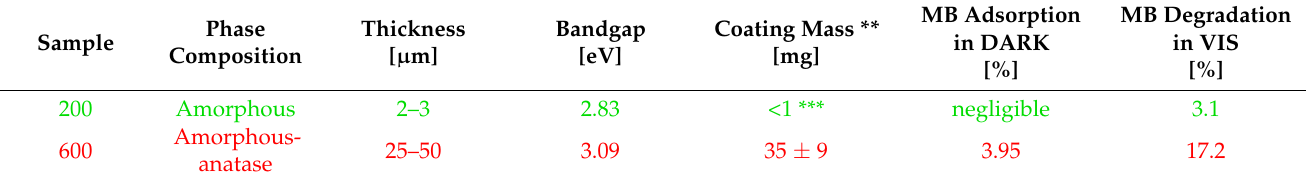
Table 2. Summary of the characterization of the samples 200 (green), and 600